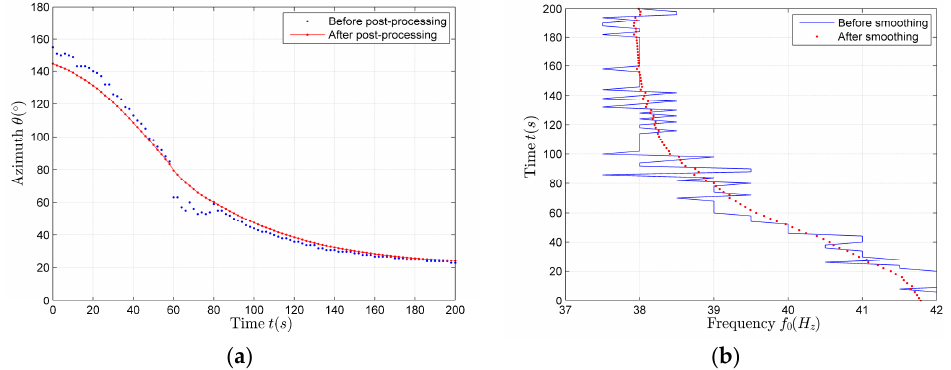
Figure 6. The estimation results of the simulation data. ( a ) Azimuth estimation results; ( b ) Source base frequency estimation results. frequency estimation